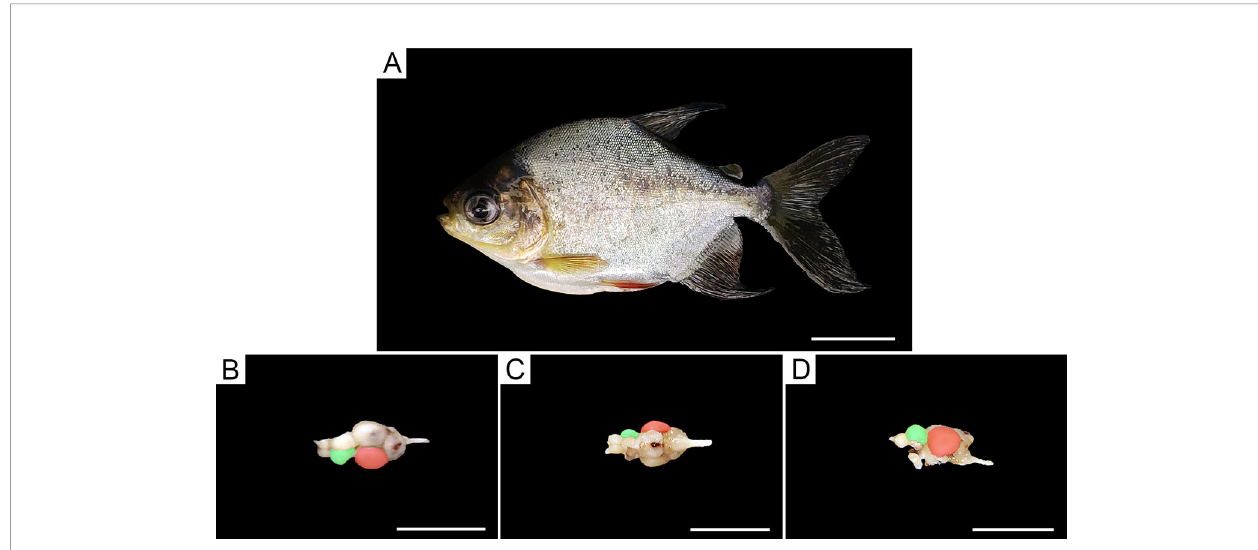
FIGURE 3 | C. macropomum specimen (A) and brain in the dorsal (B) , ventral (C) , and lateral (D) views. Stereological cell counts were done in the telencephalon (green area) and tectum opticum (pink area). Scale bars: (A) = 2 cm, (B , D) = 1